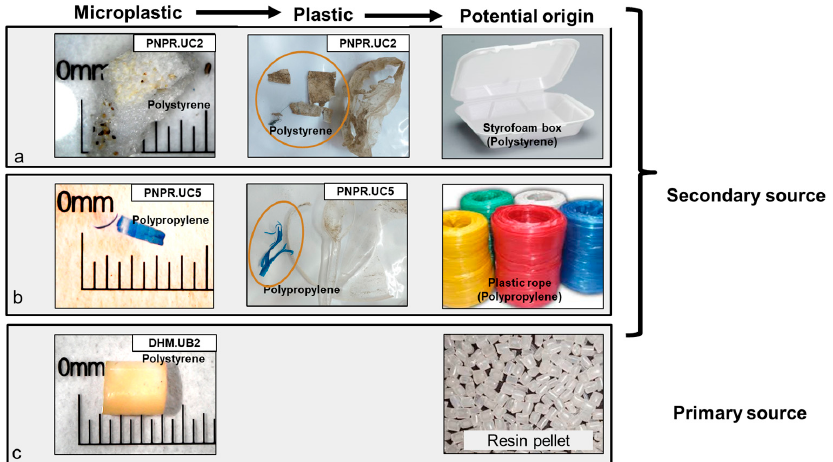
Figure 4. Potential origin of microplastic and plastic in beach sand in this study (PNPR.UC2,